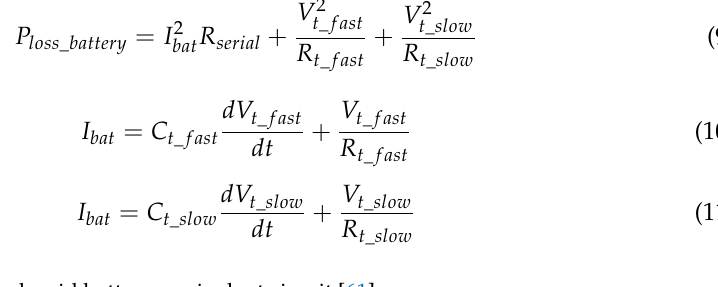
Table 2. Parameters of lead–acid battery equivalent circuit